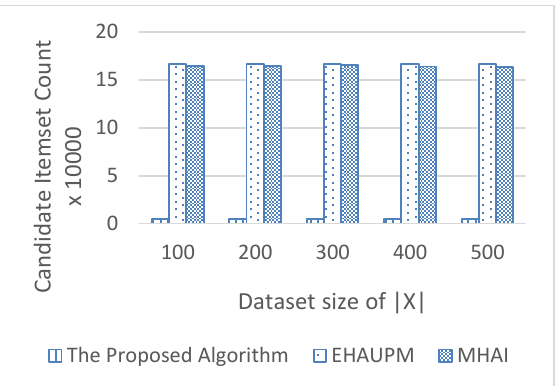
Dataset size of |X| The Proposed Algorithm EHAUPM Figure 7. Candidate itemset counts for various dataset sizes on T35 I100D